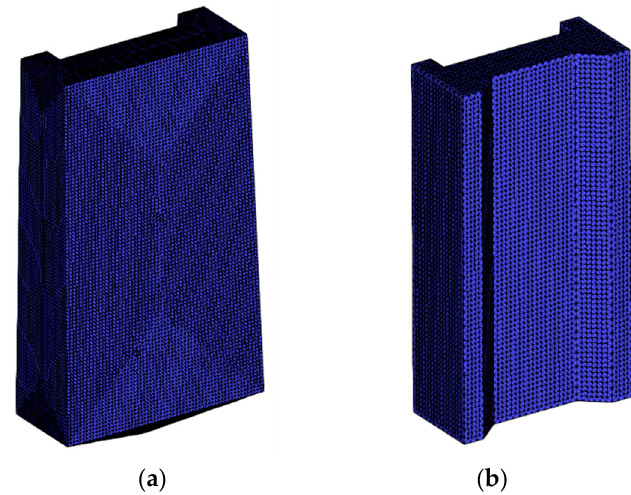
Figure 6. Apparatus of wear part and particle domain.